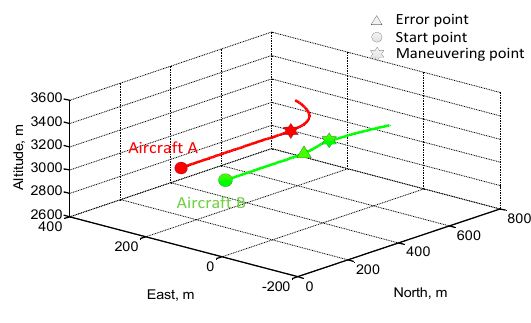
Figure 9. 3D flight path. Figure 9. 3D flight